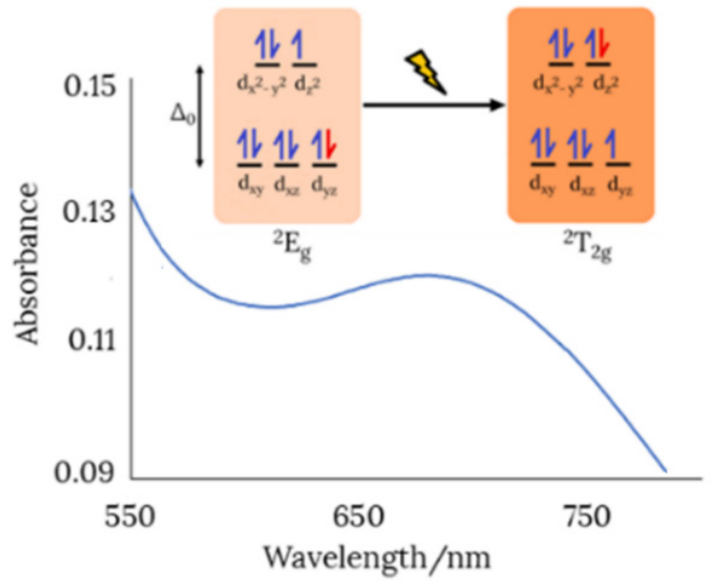
Figure 5. View of the d-d transition in the UV-Vis spectrum of the dimeric copper(II) complex (in ethanol).